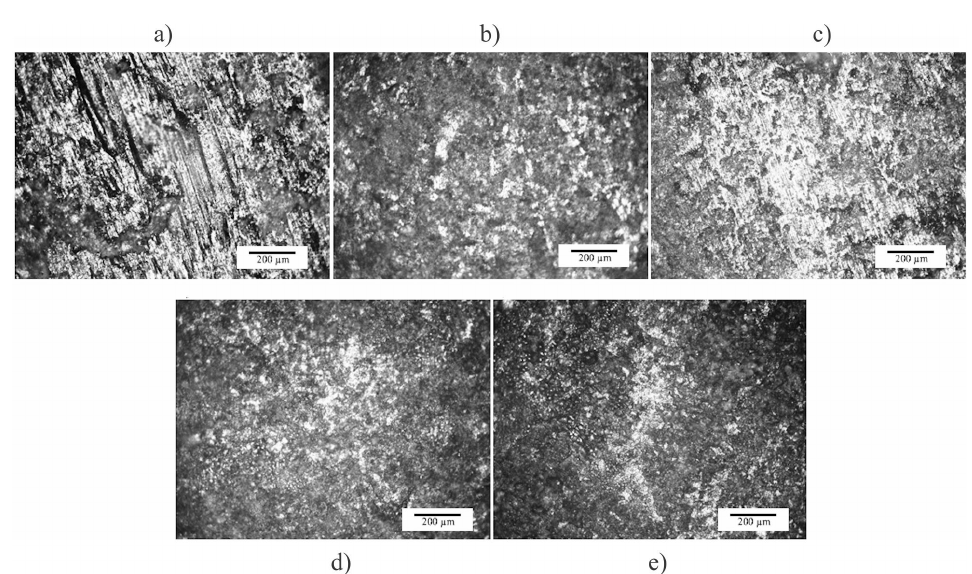
Figure 7. Adhesion tests of samples coated with Ni/NiO: J1 (a), J2 (b), J3 (c), J4 (d) and J5 (e). Table 6. Pencil hardness test results in increasing order of coatings. Sample